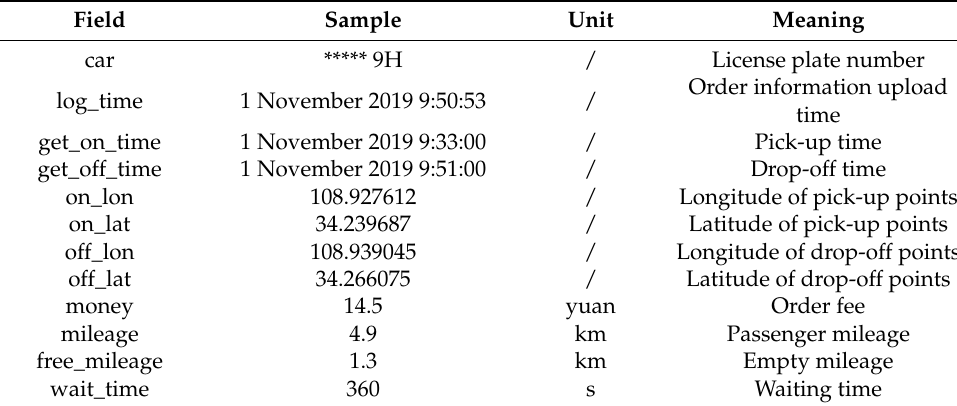
Figure 2. Description of taxi order data. Table 2. Taxi order data